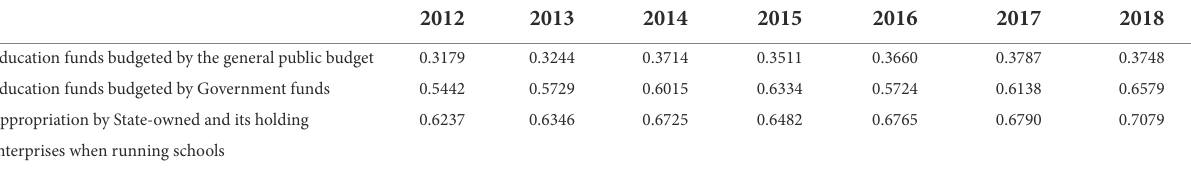
TABLE 6 Gini coefficients for different sources of interprovincial financial education